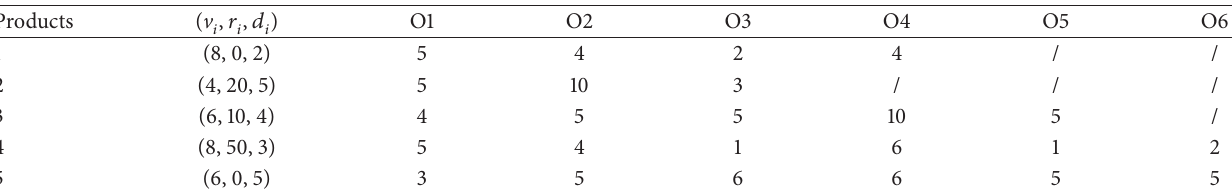
Table 1: Product